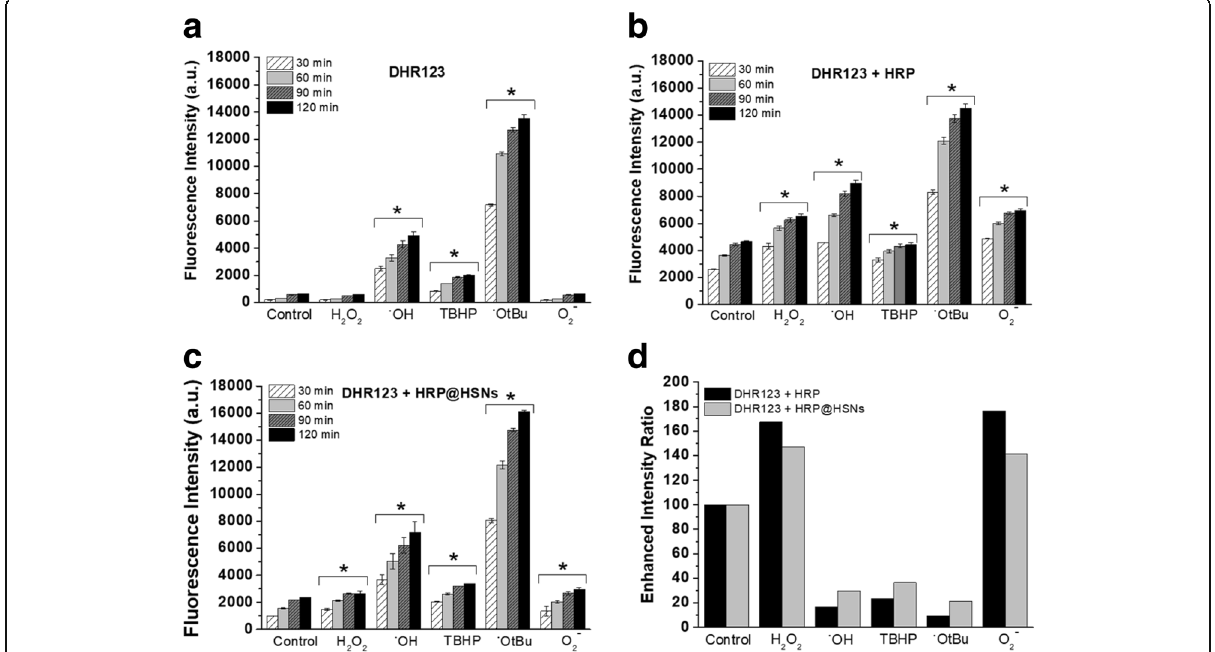
Fig. 2 a – c Time-dependent fluorescence intensity of the reaction of selected reactive oxygen species (ROS) with a dihydrorhodamine 123 (DHR123), b DHR123+horseradish peroxidase (HRP), and c DHR123+horseradish peroxidase-encapsulated HSNs (HRP@HSNs). d Enhanced intensity ratio of the reaction of selected ROS with DHR123+HRP and DHR123+HRP@HSNs at 1 h. Data shown are for 20 μ M of DHR123, 400 ng/mL of HRP, 50 μ g/mL of HRP@HSNs, and 100 μ M of ROS. (* p <0.05 versus the control group at corresponding time